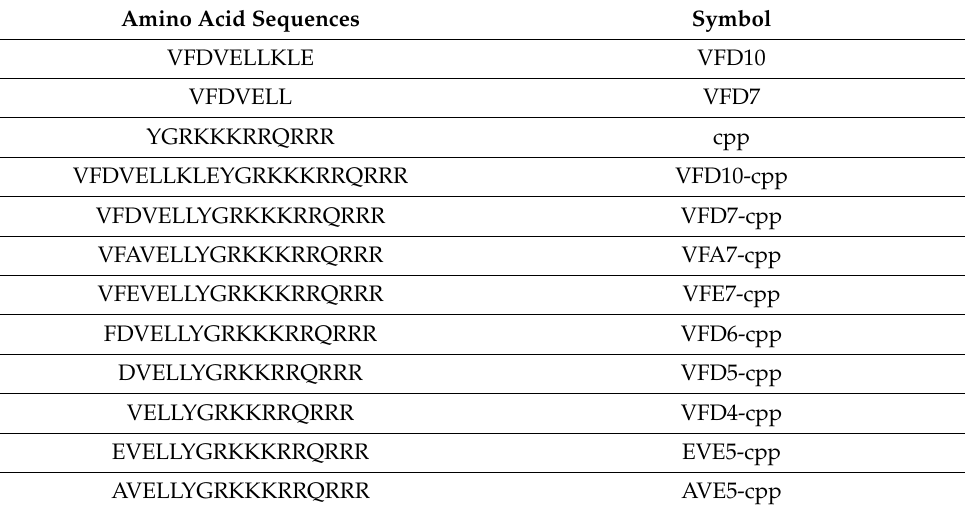
Table 1. Amino acid sequence of peptides investigated